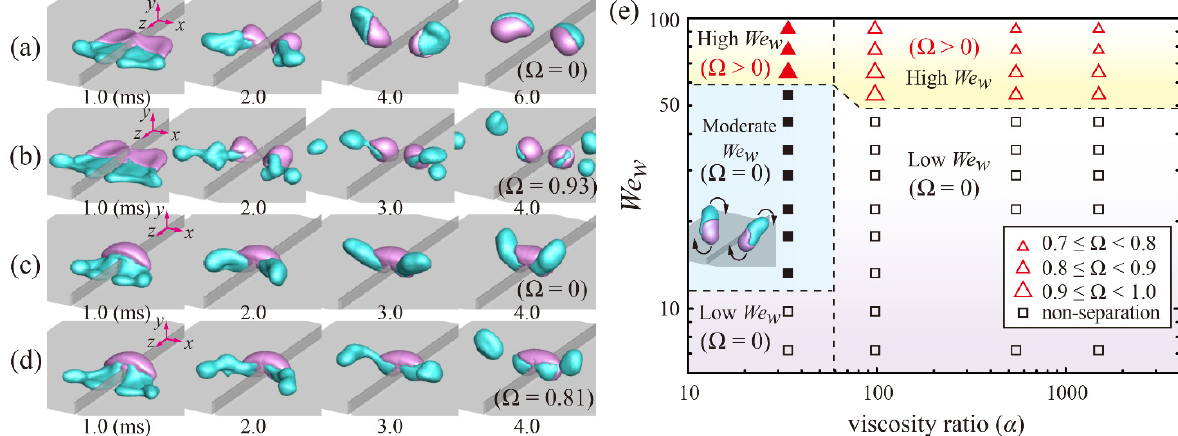
Figure 3. Bouncing characteristics depending on the impact velocity and viscosity ratio at D 0 = 1.33 mm. ( a – d ) Morphological behavior of the impinging drops at ( a , b ) We w = 44 and 65 under the viscosity ratio of α 1 , respectively, and ( c , d ) We w = 44 and 65 under the viscosity ratio of α 3 , respectively. ( e ) Regime map of We w as a function of the viscosity ratio. Triangle and square symbols in the map indicate separation/non-separation situations between W- and G-parts, respectively; filled and open symbols represent fragmentation/non-fragmentation situations for G-part, respectively. The Weber numbers can be characterized into three regimes based on the separation between the two parts and the fragmentation of G-part: low- We w (W-part still adhering to G-part), moderate- We w (symmetric division of G-part by the ridge, but Ω = 0), and high- We w regimes (W-part separated from G-part).